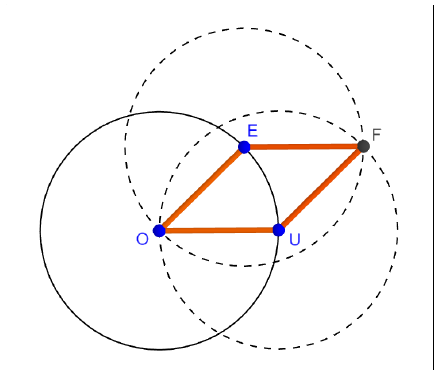
Figure 11. A square